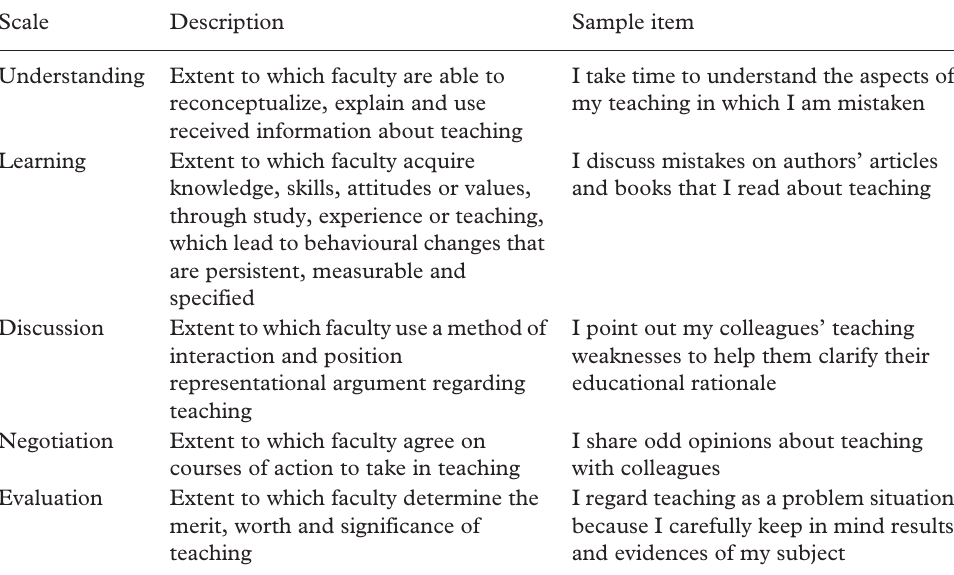
Table 1. Description of scales and a sample item for each scale of the ACLQ Scale